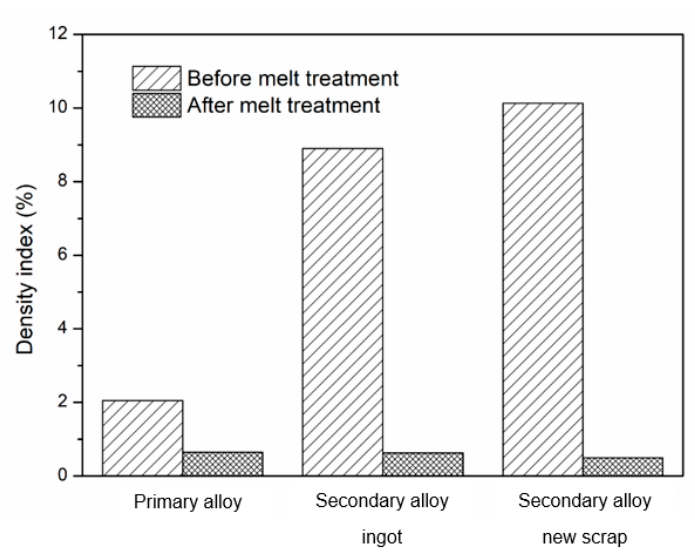
Figure 5. Density index values for the three alloys at different stages (before and after the melt treatment).